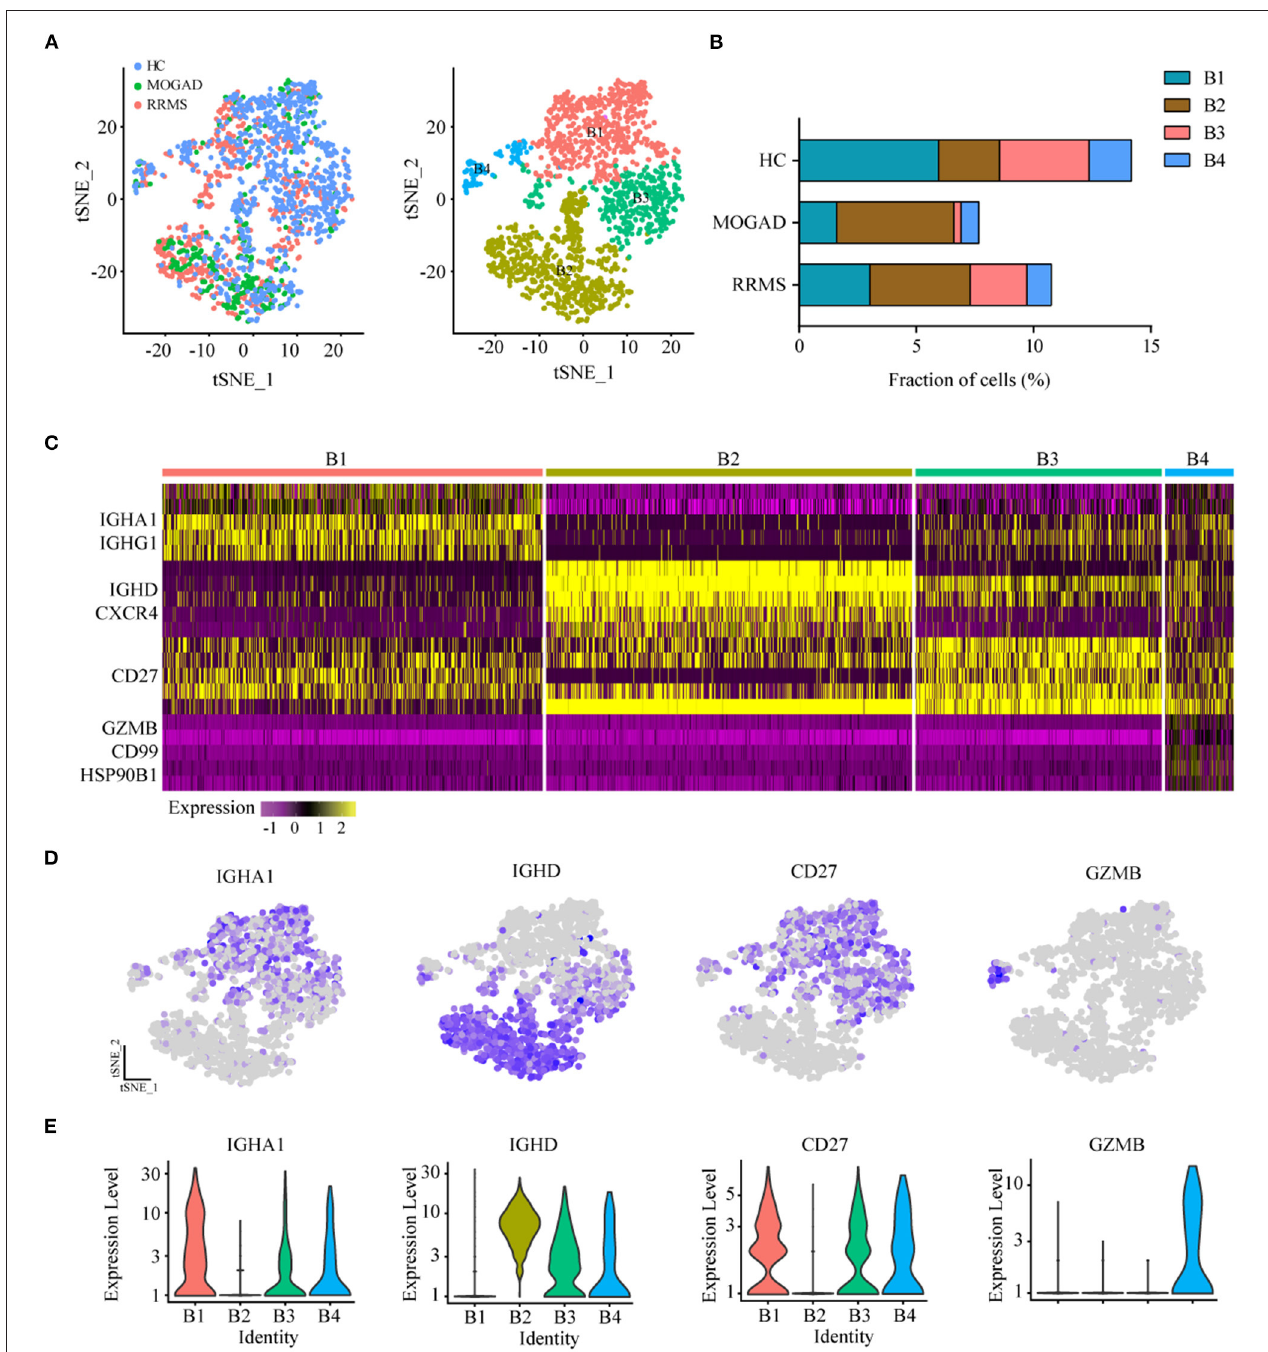
FIGURE 4 | Analysis of B cell clusters from HC, RRMS, and MOGAD. (A) tSNE visualization of B cells from HC, RRMS, and MOGAD. (B) The percentage of cells for B cell subsets in HC, RRMS, and MOGAD. (C) Heatmaps shows the expression of the up- and downregulated markers in B cell subsets. (D) The expression level of marker gene in each B cell type was shown. (E) Violin illustration shows the expression of the marker genes from different B cell types. HC, healthy controls; RRMS, relapsing-remitting multiple sclerosis; MOGAD, myelin oligodendrocyte glycoprotein (MOG) antibody-associated disease. PBMC, peripheral blood mononuclear cell; tSNE, t-Distributed Stochastic Neighbor Embedding. (B1) and memory B cells (B3) numerically was reduced in MOGAD. In summary, four different subsets were